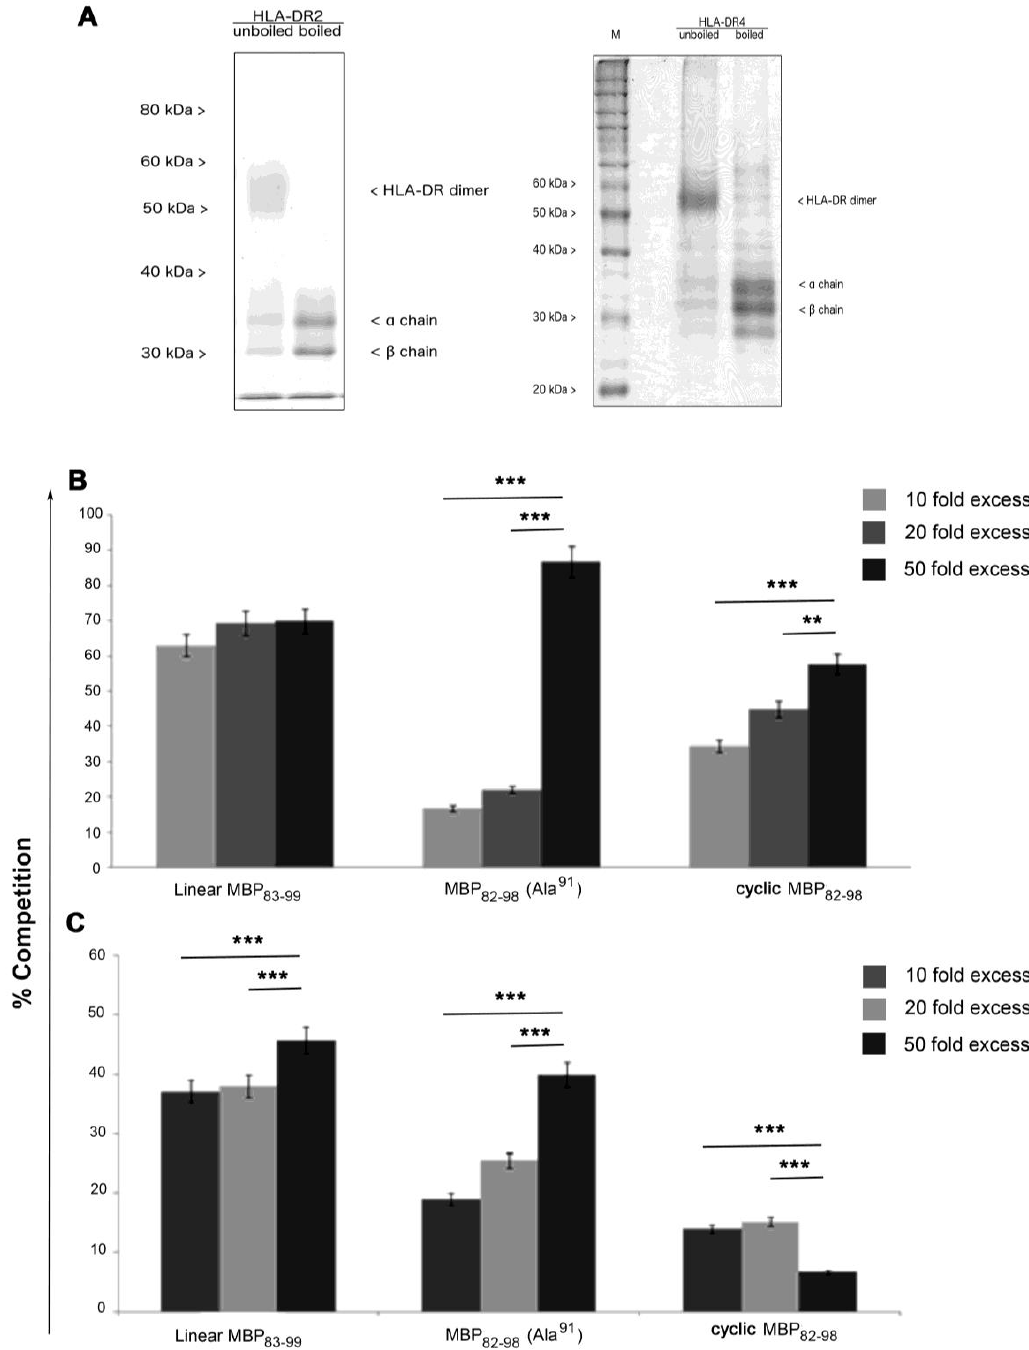
Figure 4. ( A ) SDS-PAGE analysis (12%) of detergent solubilized HLA-DR2 (DRB5*0101/DRB1*1501; left) or HLA-DR4 (DRB1*0401; right) where 5–8 × 10 9 of the Epstein Barr virus (EBV)-transformed B cell line HTC-LAN and BSM were lysed, respectively, and their affinity was purified using the immobilized monoclonal antibody L243. After concentration on a 30-kDa membrane, 670–700 g of the human leukocyte antigen (HLA)-II were obtained and stored in phosphate buffered saline at a concentration of 0.5 mg/mL. The purity of HLA-DR2 and HLA-DR4 were about 85%. ( B ) Competition binding of the MBP 82–98 peptide analogues in 10-fold, 20-fold, and 50-fold excess of AMCA-labeled MBP 83–99 , which is specific to the HLA-DR2b chain, was used as the peptide competitor, and ( C ) AMCA-labeled HA 306–318 , which is specific to the HLA-DR4, was used as the peptide competitor. All of the experiments were in triplicates, where ** p < 0.01 and *** p < 0.001.